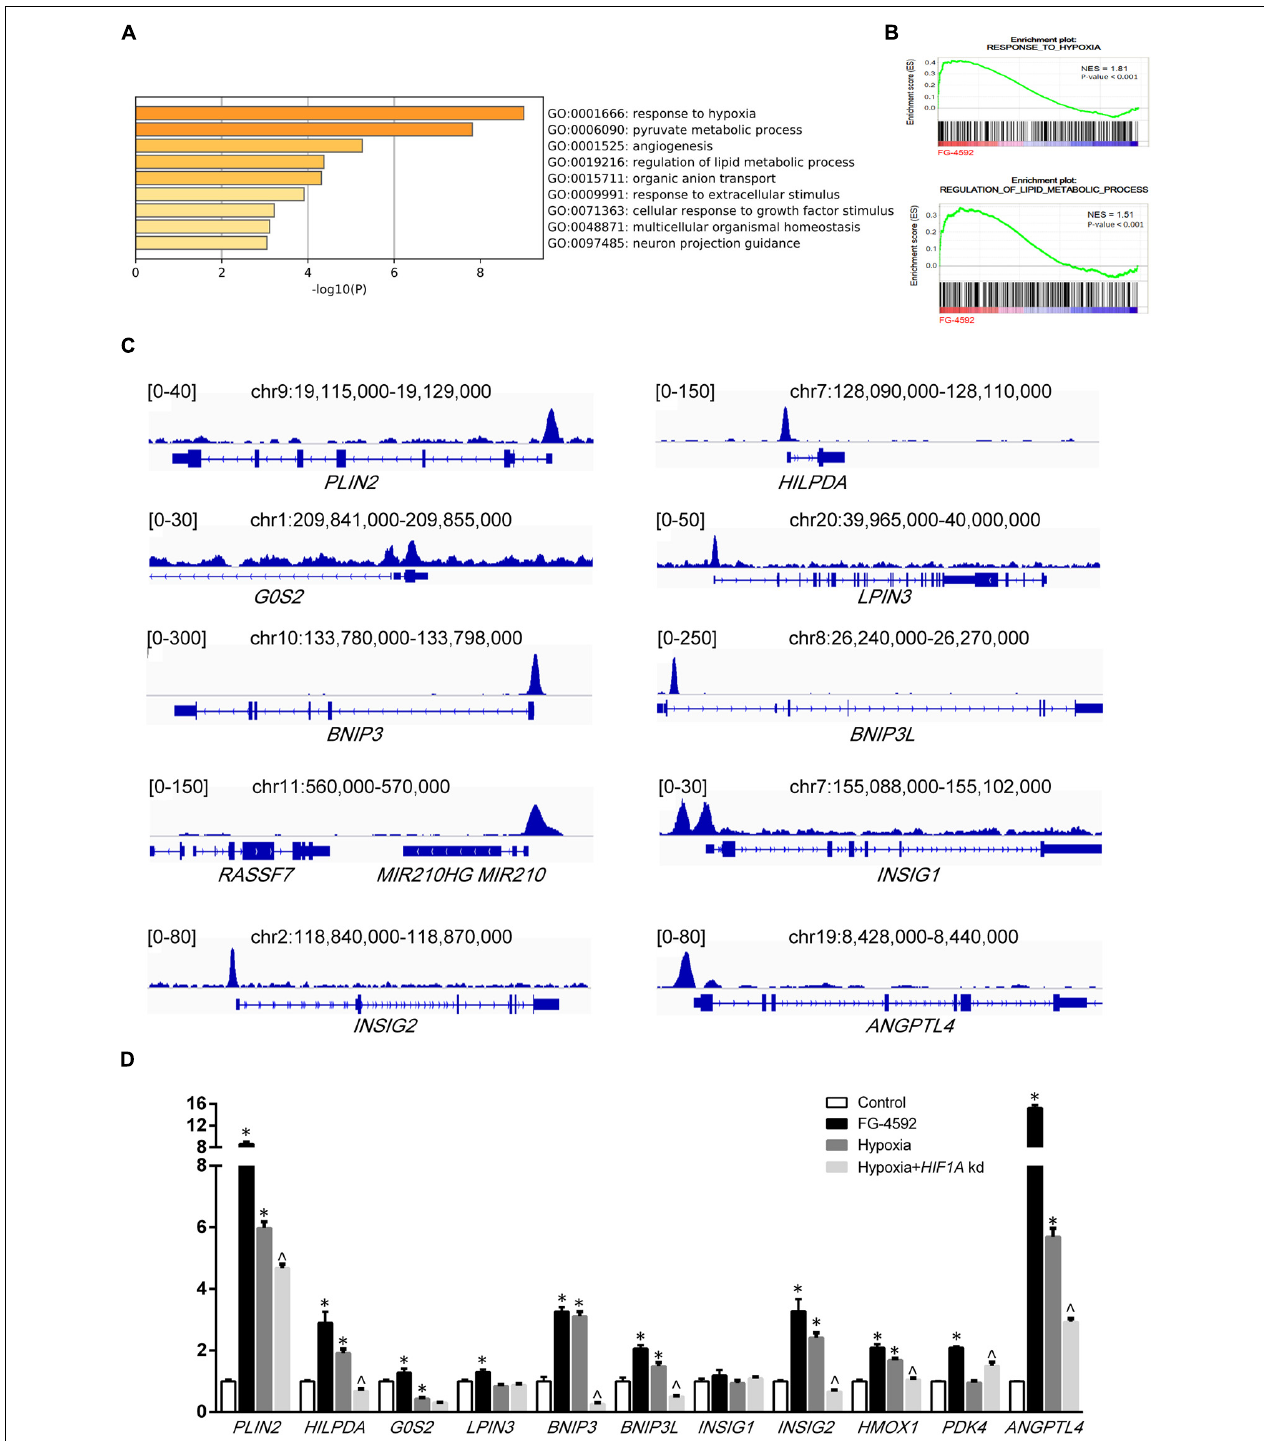
FIGURE 2 | Direct transcriptional regulation by HIF1 α . (A) Functional annotation clustering showed enriched Gene Ontology (GO) terms for biological processes among significantly differentially expressed genes in FG-4592-treated HK2 cells (6 h). (B) Enrichment plots from the GSEA performed for GO categories on transcriptomic profiling of HK2 cells treated with and without FG-4592. NES, normalized enrichment score. (C) Schematics of respective gene loci with HIF1 α ChIP-seq peaks from HK2 cells under FG-4592 treatment. (D) Determination of gene expression levels in HK2 cells cultured in normoxia or in 6-h hypoxic (0.1% O 2 ) conditions by RT-qPCR. FG-4592 was added simultaneously to groups indicated. HIF1A kd: HIF1A knockdown by siRNA. Statistical analysis was performed using Student’s t test. * p < 0.05 vs control groups; ˆ p < 0.05 vs hypoxia groups. Values are expressed as the mean ± SEM.